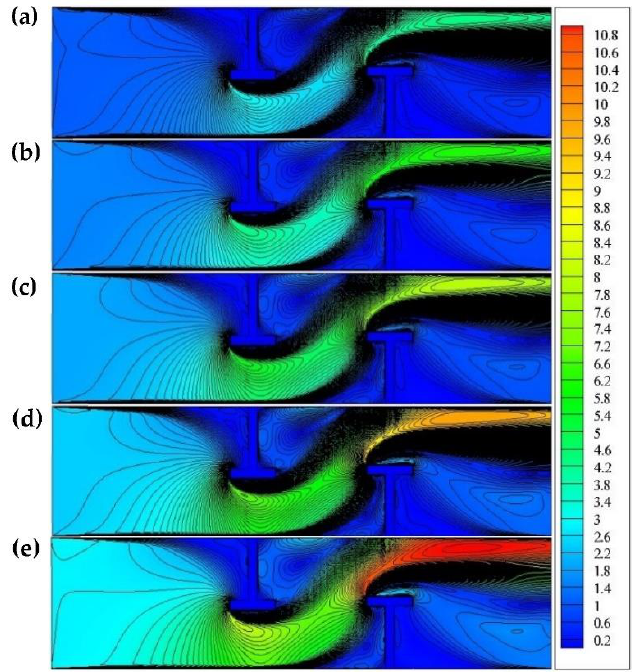
Figure 5. Velocity distribution for: Re = ( a ) 12,000; ( b ) 17,000; ( c ) 22,000; ( d ) 27,000; ( e )